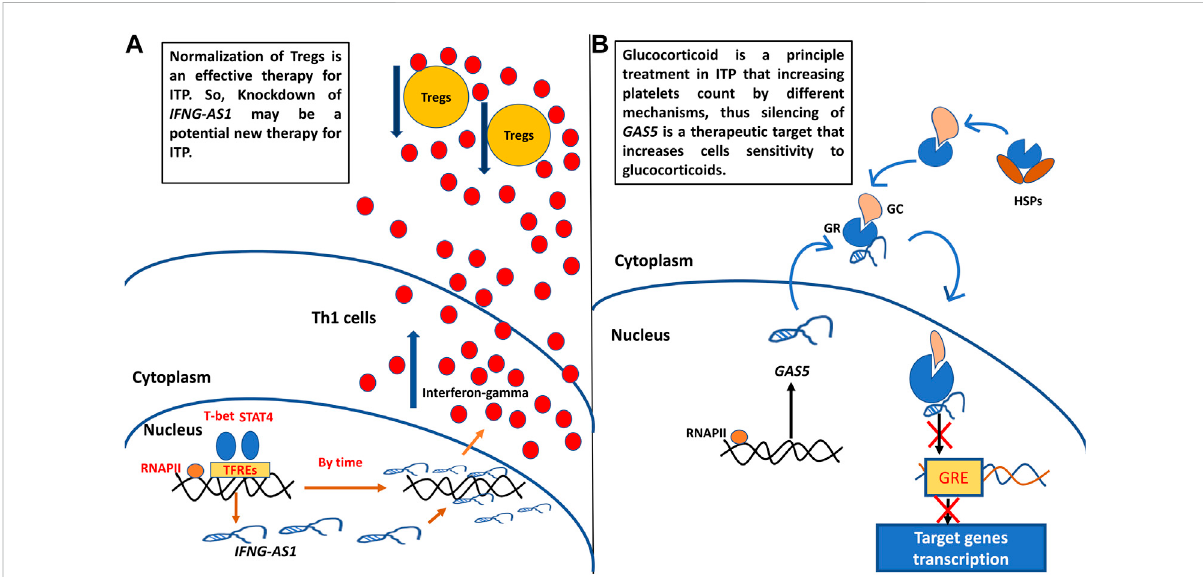
FIGURE 6 (A) Probosed function of IFNG-AS1 in childhood ITP pathogenesis and its supposed role as target of therapy. (B) Proposed function of GAS5 in childhoodITPpathogenesisanditssupposedroleastargetoftherapy.Th1:Thelpertype1cells, Tregs:regulatoryTcells,RNAPII:RNApolymeraseII, TFREs: transcription factors response elements, GC: glucocorticoid, GR: glucocorticoid receptor, GRE: glucocorticoid response